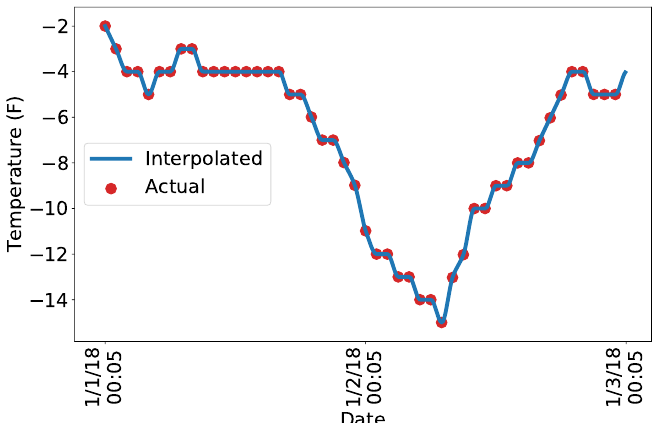
Figure 2. Representative interpolation for approximately ten days of temperature data in Philadelphia, Pennsylvania using piecewise cubic Hermite interpolating